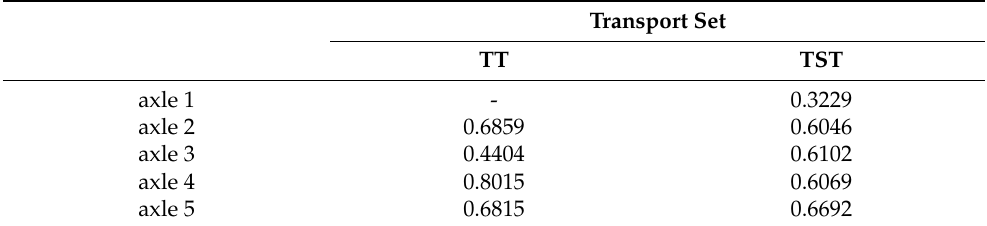
Table 3. Spearman correlation coefficients between the axle load and the GVW.